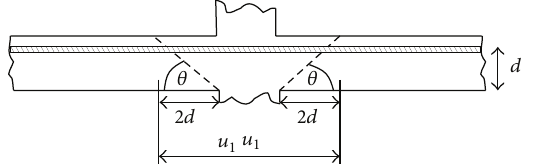
Figure 1: Distance of control perimeter from loaded face [2].